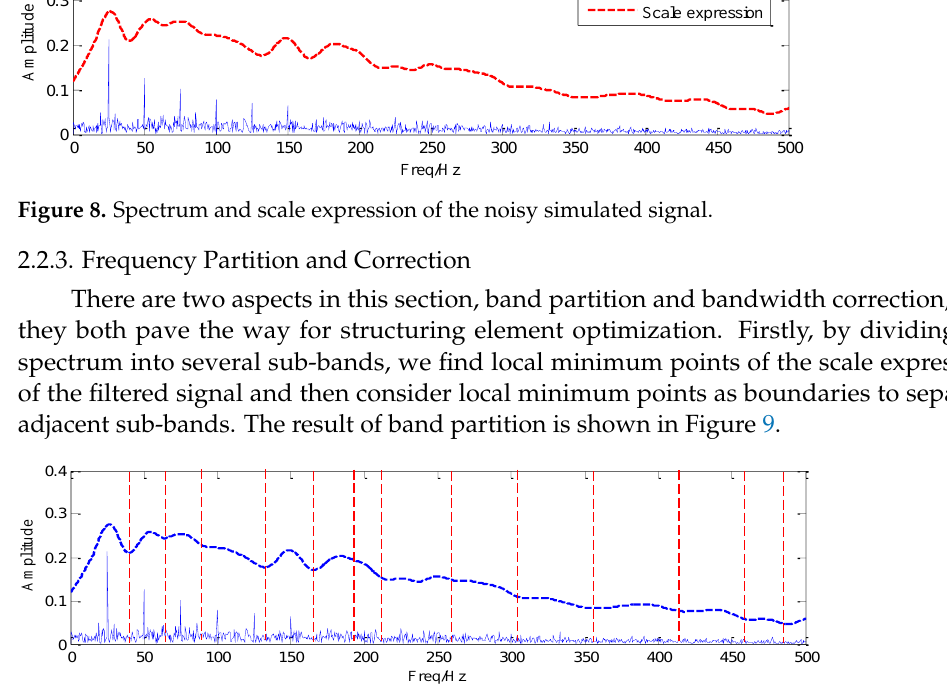
Figure 9. Result of frequency partition.